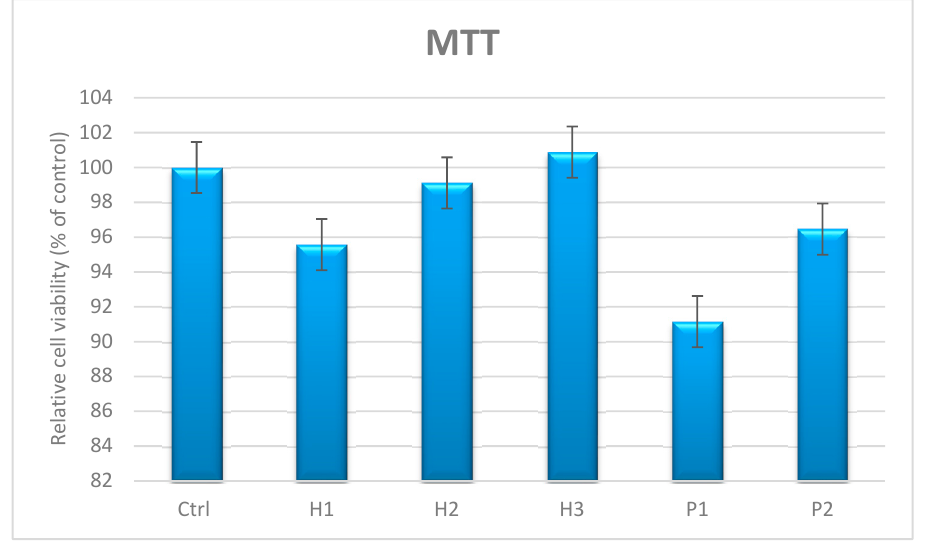
Figure 6. AFSC viability in the presence of ZnO nanoparticles.